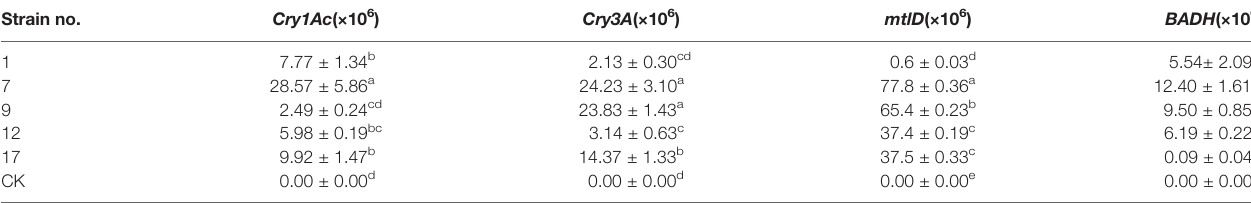
Data are means of three biological replicates. Use Duncan ’ s multiple range test, in the same column, the same letter showed that there is no signi fi cant difference, the different letters indicate signi fi cant difference, p <